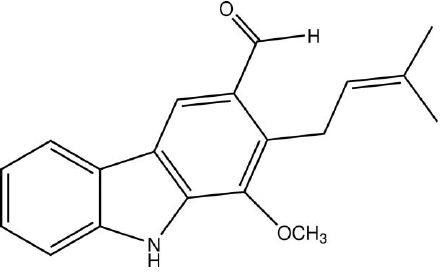
Experimental Crystal data